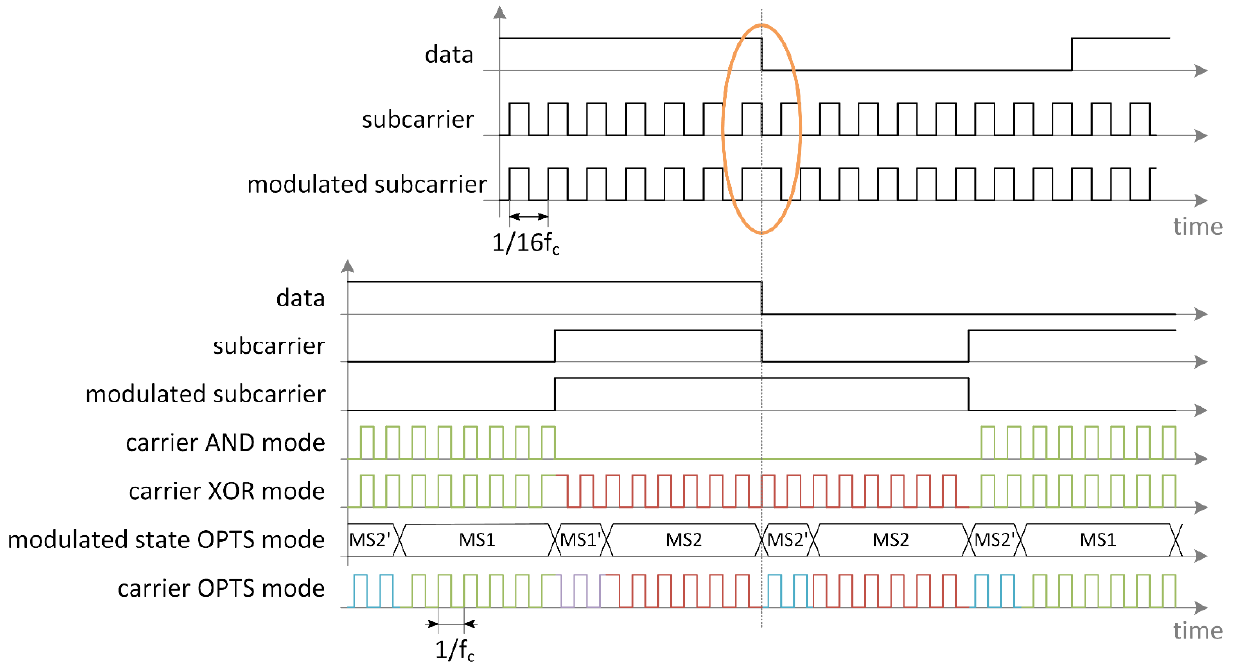
Figure 4. Timing diagrams for subcarrier and carrier modulation. In the upper part data, subcarrier and modulated subcarrier according to NFC B protocol are shown. In the lower part zoom of the section marked with orange is shown. Carrier modulation is shown for AND, XOR and OPTS mode. The carrier is colored according to modulation phase. Green carrier has reference phase, purple is 90° shifted, red is 180° shifted and blue is 270° shifted according to reference carrier.